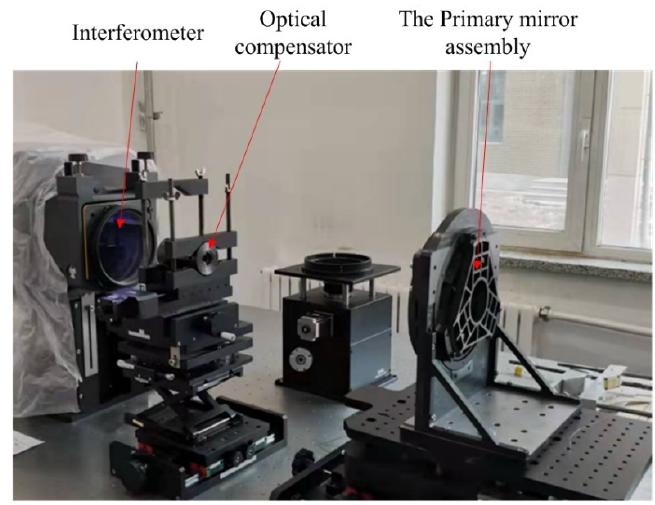
Figure 11. Interferometry scenario of the SiC primary mirror with the optical axis horizontal.